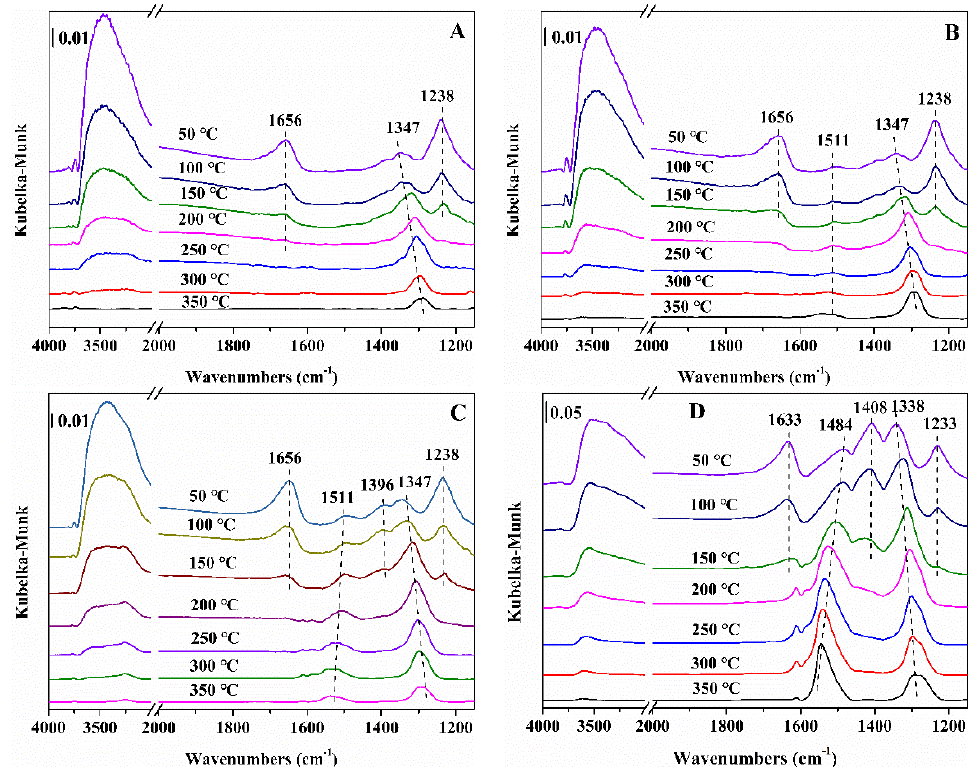
Figure 13. In situ DFIRTs of spectra of ( A ) MnAlO x -450 °C, ( B ) MnAlO x -550 °C, ( C ) MnAlO x -700 °C, ( D ) MnAlO x -800 °C catalysts under atmosphere of 500 ppm of NO + 6.5 vol. %/N 2 (100 mL/min) at 50, 100, 150, 200, 250, 300, and 350 °C.